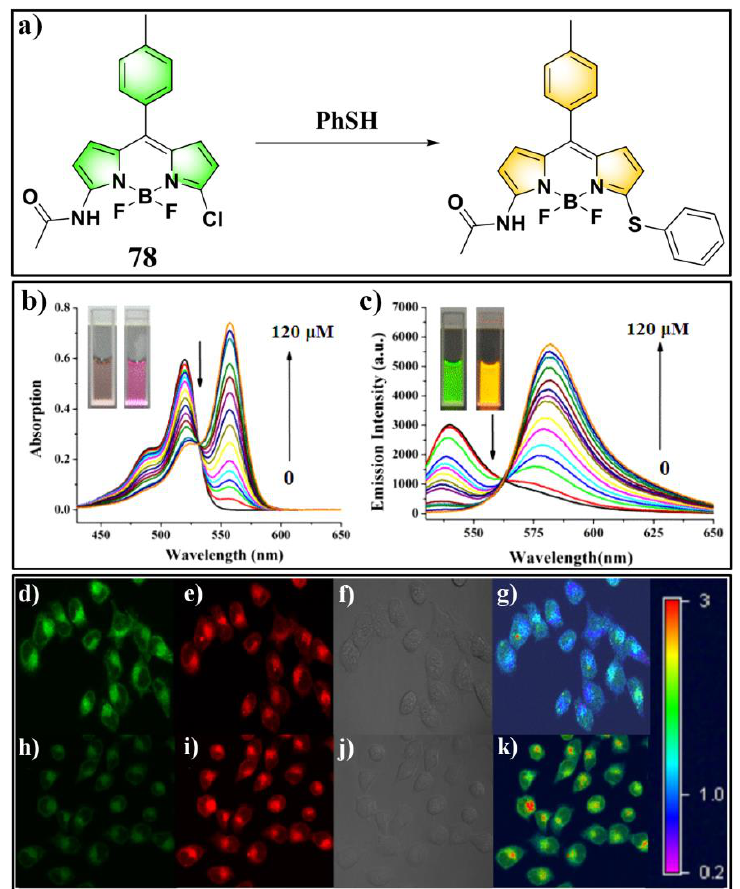
Figure 28. ( a ) Structure and reaction of probe 78 for PhSH. ( b ) Absorption and ( c ) emission spectra of 78 in the presence of PhSH with different concentrations. ( d–k ) Confocal fluorescence images of living HeLa cells: ( d–g ) cells loaded with probe 78 ; ( h–k ) PhSH-incubated cells loaded with probe 78 ; ( d , h ) green channel images (500–550 nm); ( e , i ) red channel images (570–620 nM); ( f , j ) bright-field images; ( g ) ratio image merged from ( d , e ); ( k ) ratio image merged from ( h , i ). Reproduced with permission from Reference [156]; copyright 2017 Elsevier B.V., New York, NY, USA.